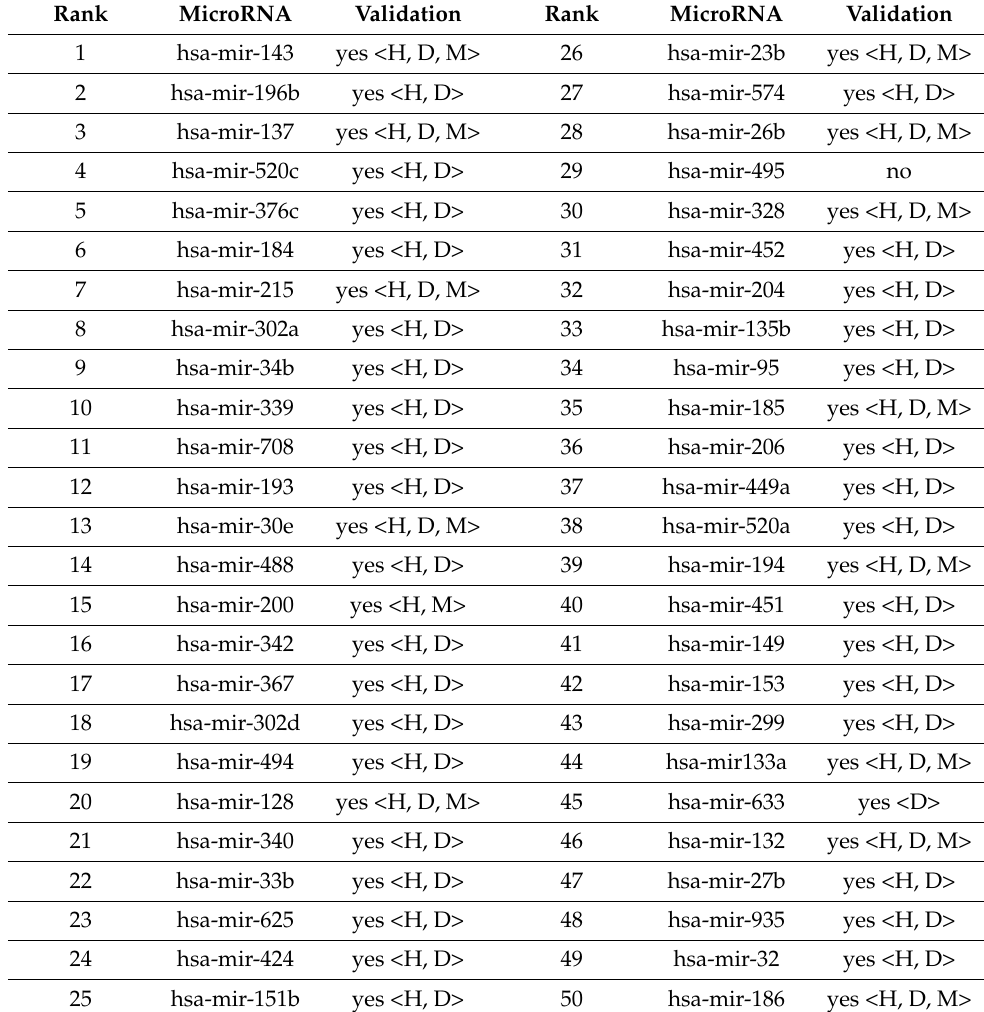
Table 5. Top 50 miRNAs predicted by HLGNN-MDA to be associated with hepatocellular carcinoma.